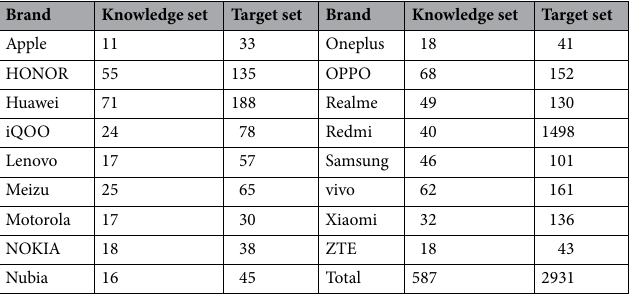
Table 2. Device number of different brands in knowledge set and target set.